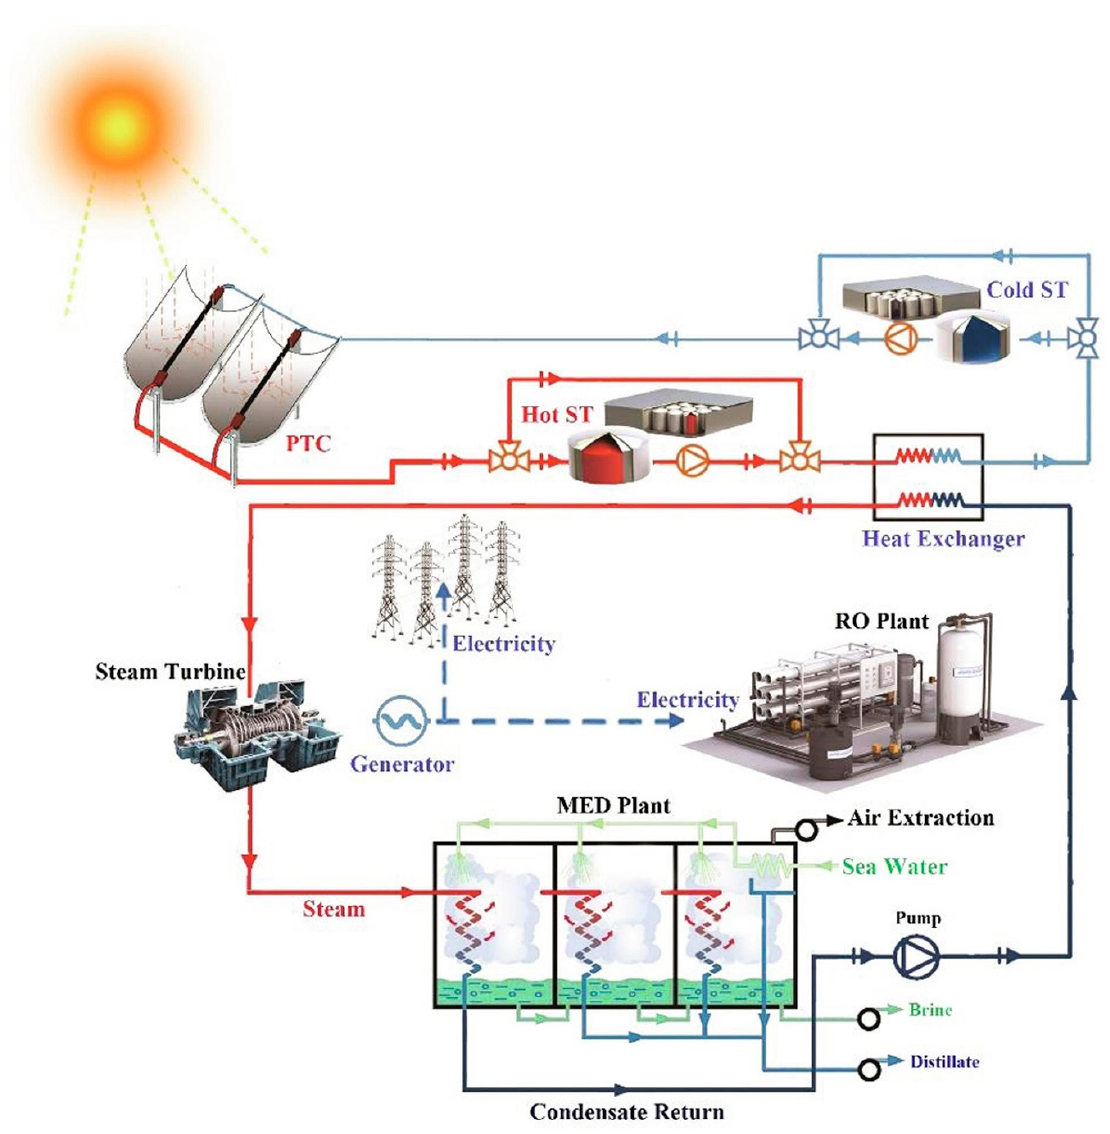
Figure 7. Configuration of the proposed system [83], reused with permission from Elsevier (license number 5491421034545).